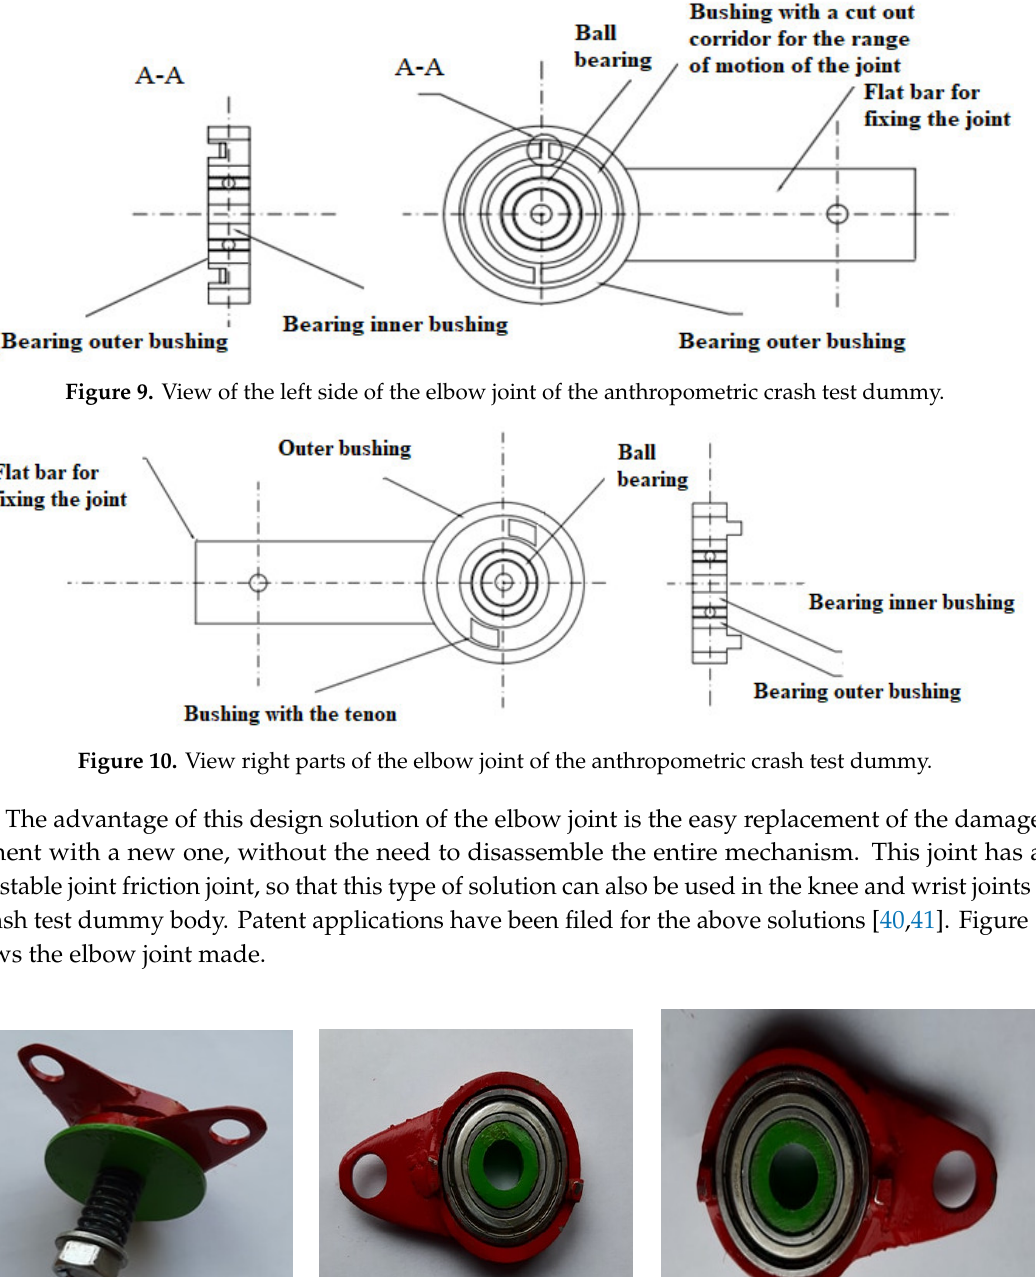
Table 2. Maximum value of the rotation joint of the anthropometric dummy and the Hybrid III dummy representing the 50th percentile male.